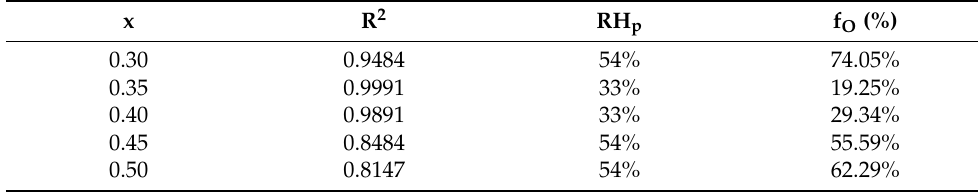
Figure 4. ( a − d ) The complex impedance diagrams of Na 0.5 Bi x TiO 3 . Figure 4. ( a – d ) The complex impedance diagrams of Na 0.5 Bi x TiO 3 . Table 1. Humidity response linearity (R 2 ), humidity of physical adsorption (RH p ), and the fractions of oxygen vacancies (f O ) for the Na 0.5 Bi x TiO 3